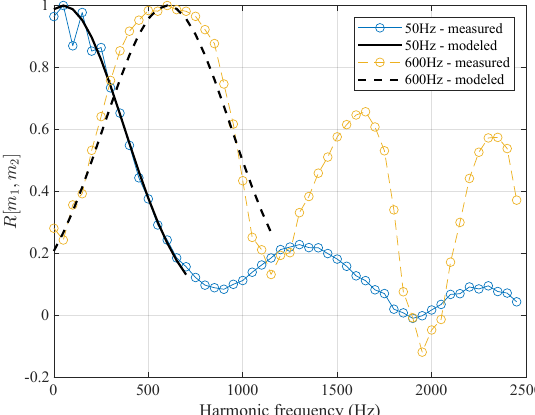
Figure 10. An example of the reconstructed signal ˆ y compared to the original signal.